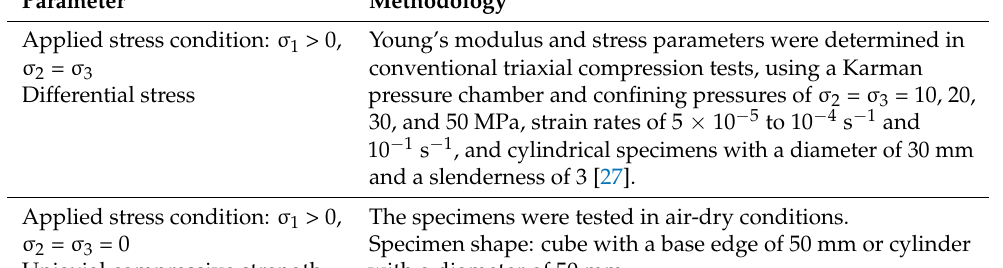
Table 2. Detailed methodology for testing mechanical parameters of coal. Parameter